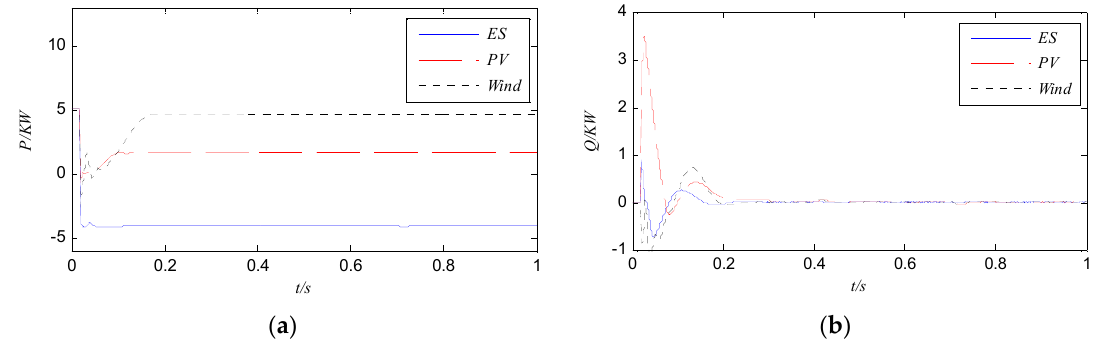
Figure 18. Active and reactive power output curves of micro ‐ source. ( a ) Active power output; ( b ) Reactive power output.